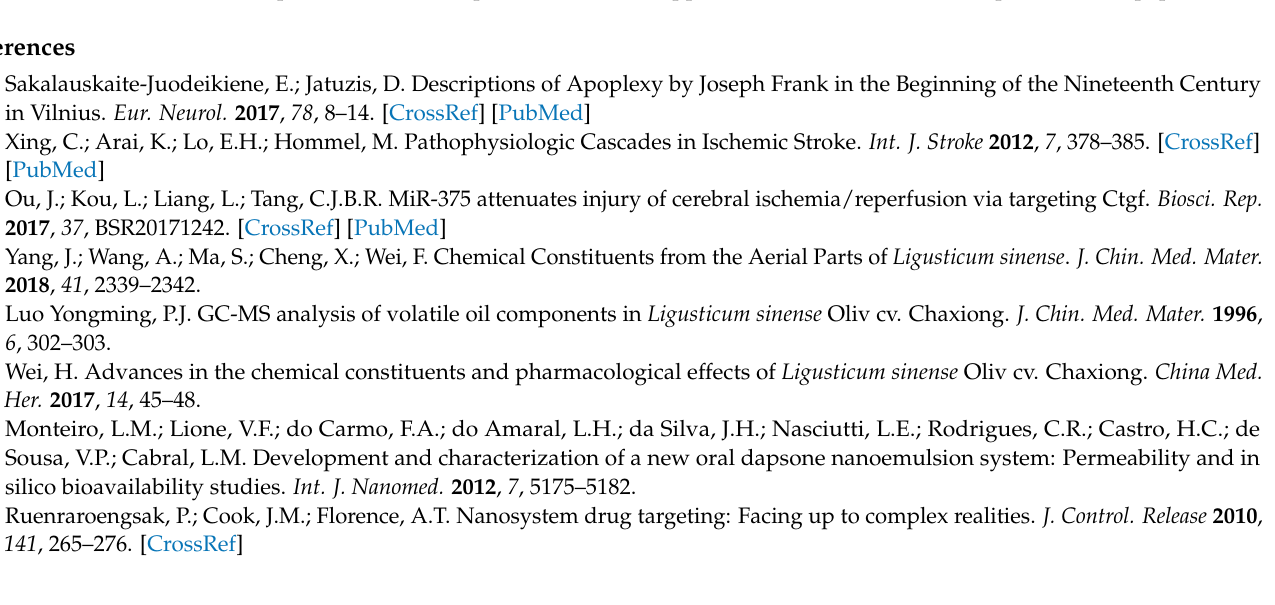
Figure S2: Bioadhesive force-measuring device. Figure S3: Solubility of VOC in different surfactants and cosurfactant. Figure S4: Pseudo ternary phase diagram. Figure S5: 3D surface and interaction plots showing the effects of the independent variables on particle size of VOC-NE. Figure S6: 3D surface and interaction plots showing the effects of the independent variables on zeta potential of VOC-NE. Figure S7: The volite oil of Chaxiong nanoemulsion. Figure S8: Identification results of VOC-NE by staining (left: Sudan red III; right: methylene blue). Figure S9: The particle size distribution and potential distribution of VOC-NE. Figure S10: Effect of P407 concentration on the gelling temperature of in situ gels. Figure S11: The effect of P188 concentration on gelation temperature. Figure S12: The effect of P407 and P188 concentration on gelation temperature of VOC-NE-ISG. Figure S13: Liquid-solid transition state of VOC-NE-ISG (left: liquid state; right: gel state). Figure S14: Rheological evaluation of VOC-NE-ISG. Figure S15: In vitro release curve of VOC-NE-ISG. Figure S16: The MCAO model rats. Table S1: Formulation of Compound Emulsifier. Table S2: Variables and their levels in the Box-Behnken design. Table S3: MS detection conditions for the five components of VOC. Table S4: Effects of surfactants on nanoemulsions. Table S5: Summary of results of regression analysis for the considered responses Y1–Y3. Table S6: Predicted versus observed values of optimized VOC-NE. Table S7: Fitting results of in vitro release model of VOC-NE-ISG ( n = 3, X ± SD). Table S8: Pharmacodynamic evaluation of VOC-NE-ISG. ( n = 10, X ±